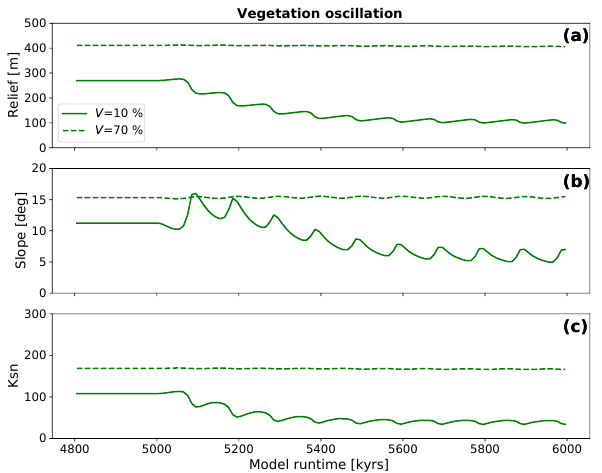
Figure 10. Evolution of topographic metrics for simulations with oscillating surface vegetation cover and constant precipitation cor- responding to the initial vegetation cover prior to the transient in vegetation cover. Panels a, b, and c show the mean basin relief, the mean basin slope, and the mean basin channel steepness ( K sn ), re- spectively.